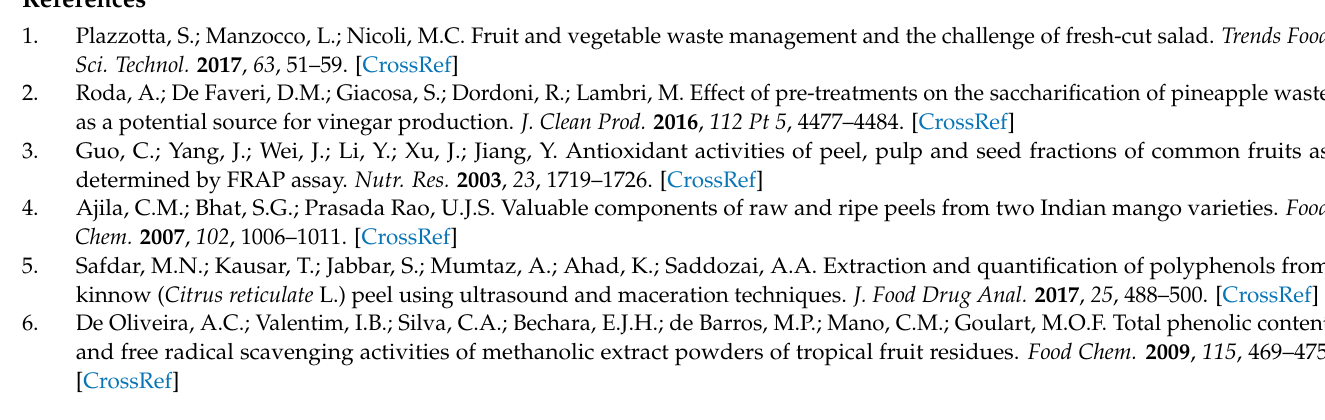
Table S1: HPLC-ESI-HRMS/MS identification of main polyphenolic compounds in the E:W 80:20 extract of pineapple